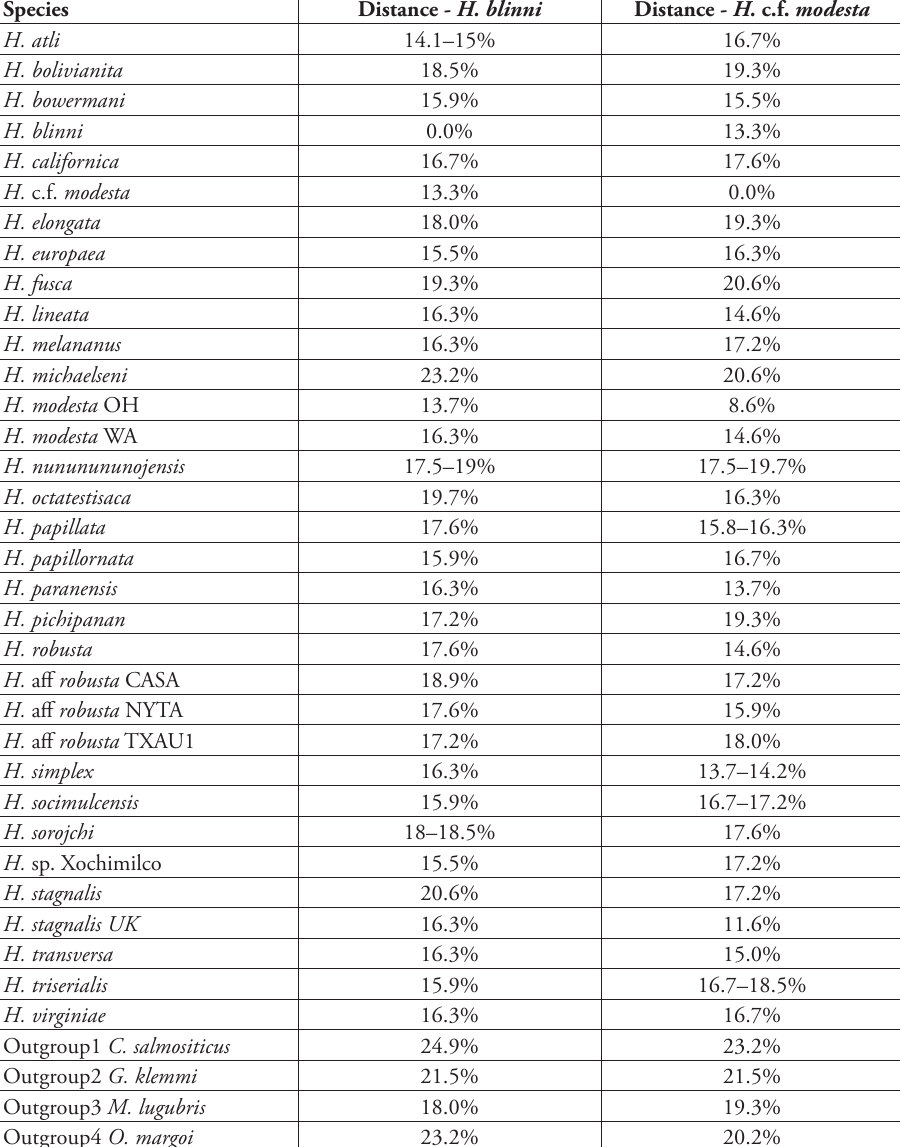
Table 6. Uncorrected p-distance pairwise analysis. Species Distance - H.